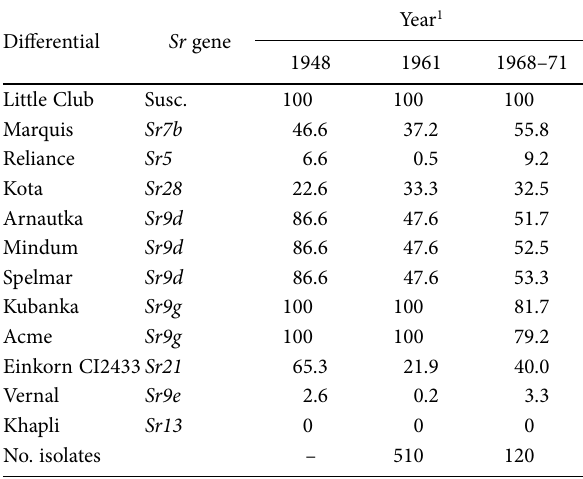
Table 6. Virulence of isolates of Puccinia graminis f. sp. tritici (stem rust) collected in Spain over several time periods and tested on a set of differentials wheat